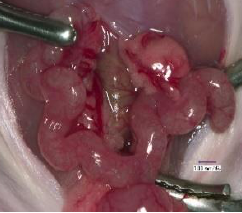
Figure 1. Injection of HVJ-E vector into uterine cavity in mice. The HVJ-E vector suspension (25 µ L/horn) was transferred into the uterine cavity using a 30-gauge needle from the oviduct side of the utero-tubal junction on day 1.5 post-coitum. The injection sites and uterine cervix were gently clamped for 10 min. The incision was then closed to allow recovery of the mice.